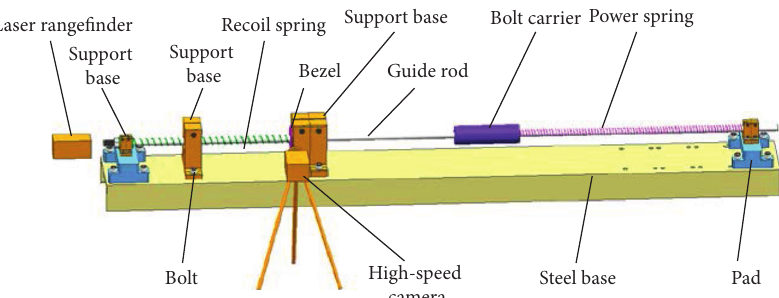
Figure 14: Schematic diagram of recoil spring impact characteristic experiment